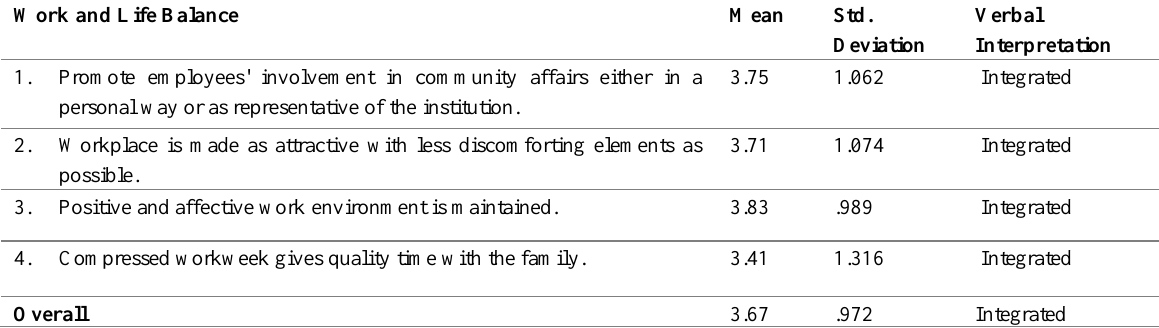
Table 11: Extent of Integration of Excellence to Work Life Balance as Perceived by Respondents Work and Life Balance Mean Std.